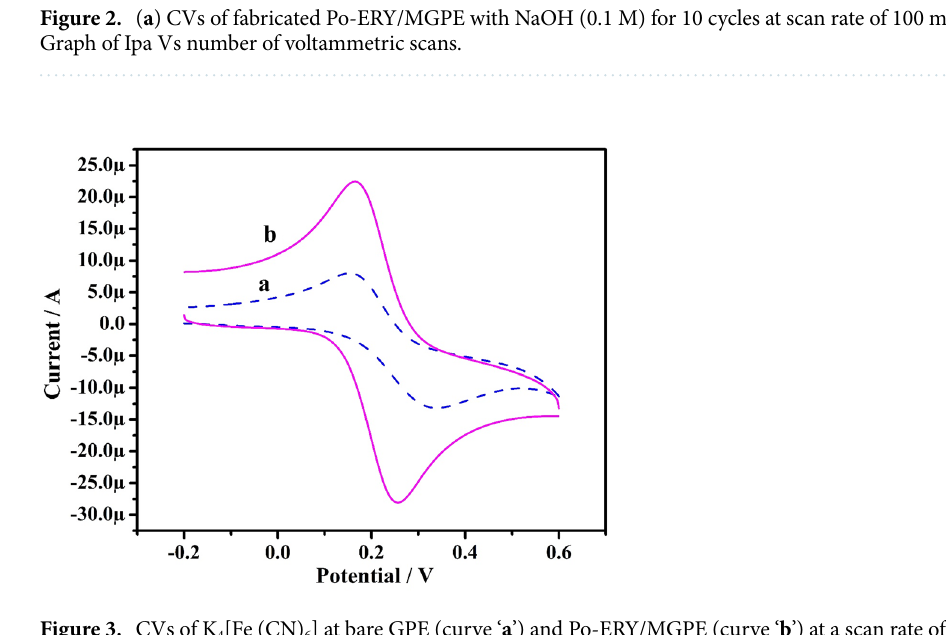
Figure 3. CVs of K 4 [Fe (CN) 6 ] at bare GPE (curve ‘ a ’) and Po-ERY/MGPE (curve ‘ b ’) at a scan rate of 50 mVs −1